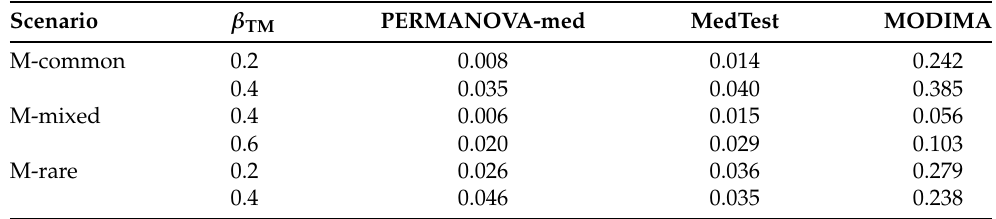
Table 2. Type I error (at the level 0.05) in analysis of simulated data with a binary exposure and a binary